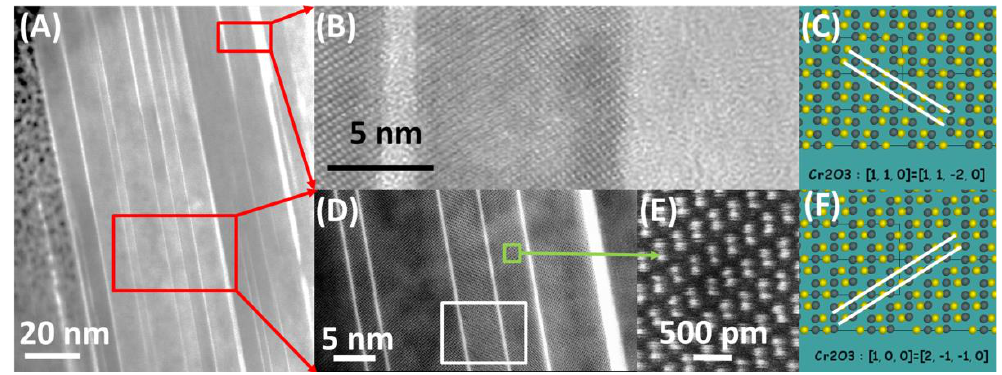
Figure 7. Oxide scale, grown on Sanicro 25 surface after 500 h of oxidation in steam at 700 °C: ( A ) STEM-BF image, ( B )–( F ) STEM-EDS elemental maps of selected elements.